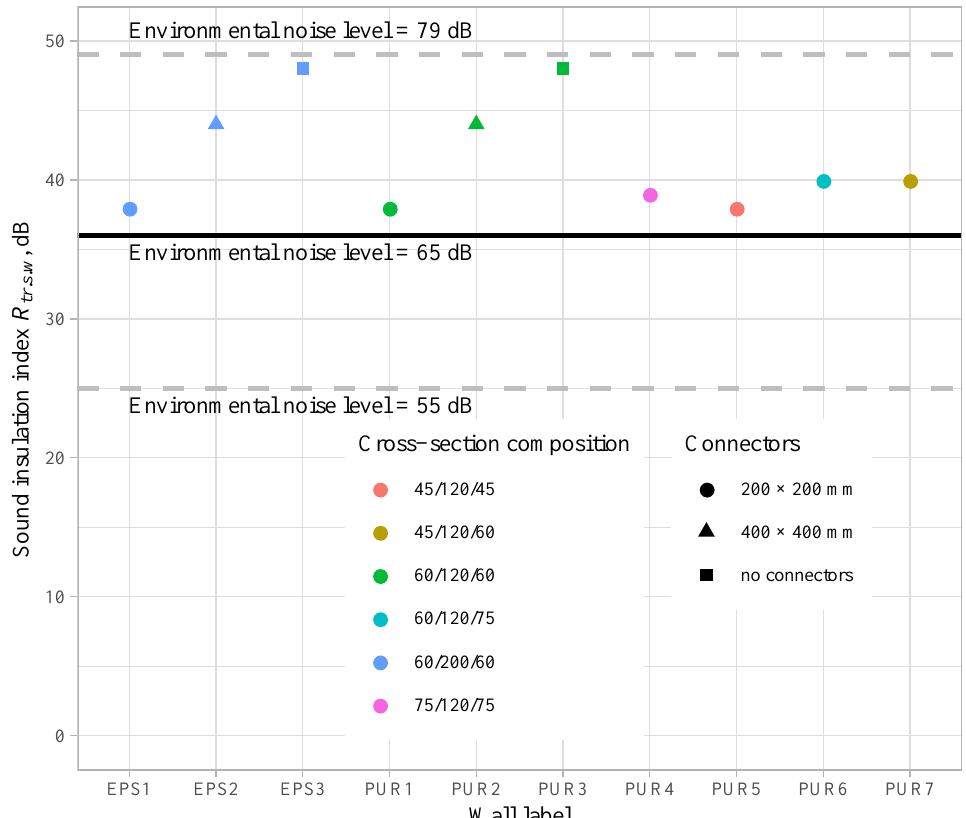
Figure 12. Comparison of the sound insulation index and the required minimum values for each SW panel analysed in this